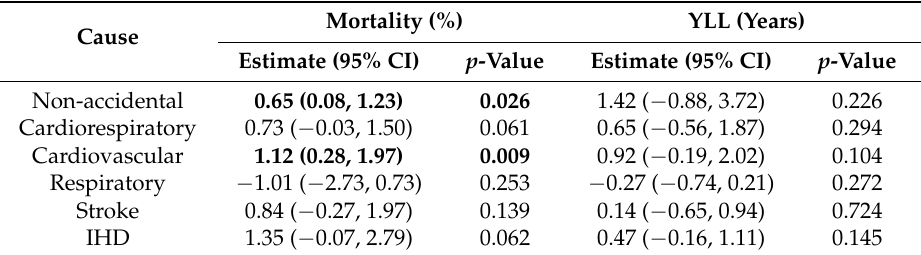
Table 3. Associations of 1 ◦ C increase in DTR at lag 0–1 days with cause-specific mortality and YLL